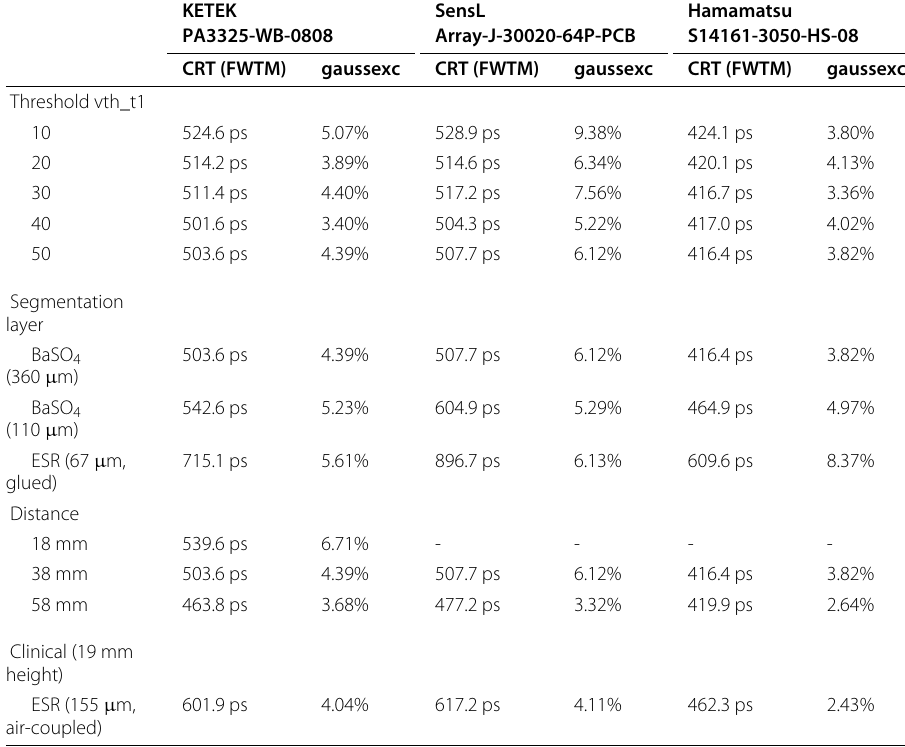
Table 3 Coincidence resolution time (FWTM) and Gaussian excess factors gaussexc KETEK SensL Hamamatsu PA3325-WB-0808